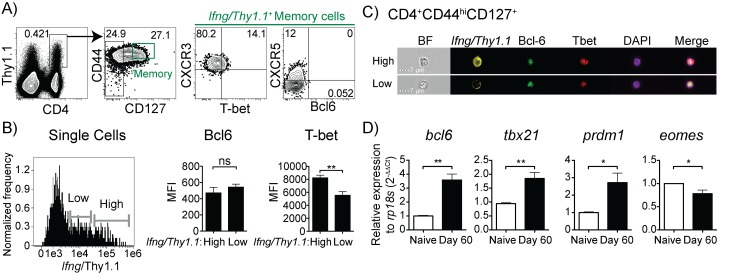
IFN-γ+ CD4 memory T cells maintain CXCR5 expression, but little T-bet.BAC-In mice were infected and splenocytes were analyzed by flow cytometry on day 60 post-infection. (A) CD4+
Ifng/Thy1.1
+ memory (CD44hiCD127+, green box, gate set on CD4+) T cells were gated and expression of CXCR3, T-bet, CXCR5, and Bcl6 was measured. Numbers represent mean percentages. (B, C) Surface staining of CD4+ T cells with CD4, CD44, CD127, and Thy1.1 (yellow) was followed by intracellular staining with Bcl-6 (green), T-bet (red), and nuclei with DAPI (purple). Cells were analyzed by imaging flow cytometry. (B) Histogram showing expression of Ifng/Thy1.1 on single focused cells. Bar graphs show MFI of Bcl6 and T-bet within Thy1.1 gates (C) Representative images of individual Ifng/Thy1.1 high and low cells showing Bcl6 and T-bet expression and localization in relation to the DAPI stained nucleus. Bright field (BF; left) and DAPI (nucleus)/Bcl6/T-bet merged images also shown (right). (D) Real time PCR analysis of bcl6, tbx21, prdm1, and eomes of CD4+Thy1.1+ sorted T cells. Results were normalized to control gene rp18s. RNA from FACS Sorted naïve (CD44loCD25-) cells from uninfected, aged-matched BAC-In mice was used as control. Data are representative of three (A) and one (B, C, D) independent experiments with 3–4 animals per group. Statistical significance shown using Students t-test. Error bars represent the SEM; ★
p < 0.05, ★★
p < 0.01, ns = not significant.